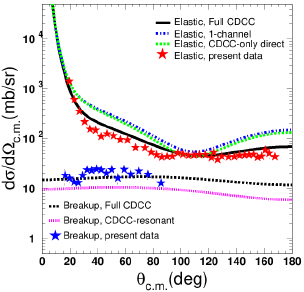
Figure 2. Experimental and theoretical angular distributions for the elastic scattering and breakup of 6 Li + p system at the energy of 25 MeV. Data and calculations from Ref.[6,